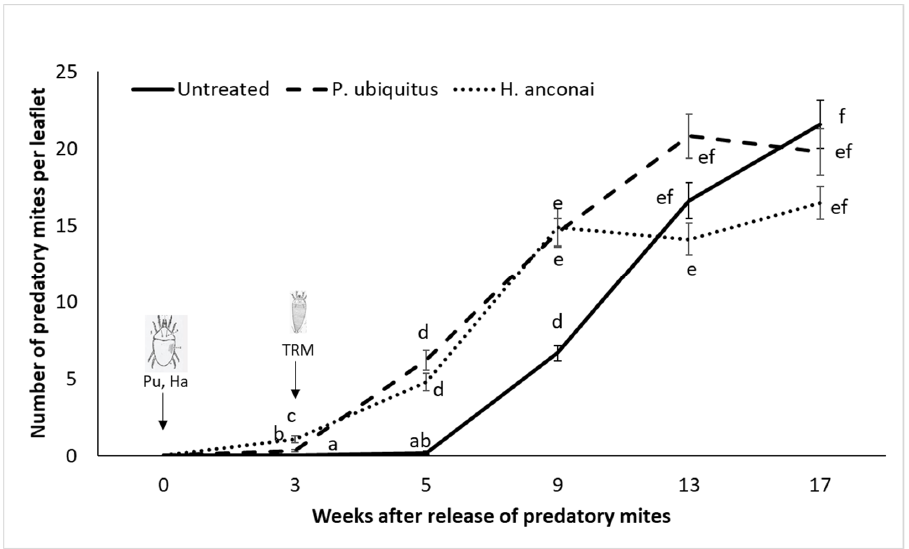
Figure 3. Population dynamics of predatory mites (Pu Pronematus ubiquitus and Ha Homeopronematus anconai ) on tomato plants for 17 weeks. Different letters indicate a significant difference in the number of iolinids between the inoculated tomato plants and the control plants (linear mixed-effects models, p < 0.05).